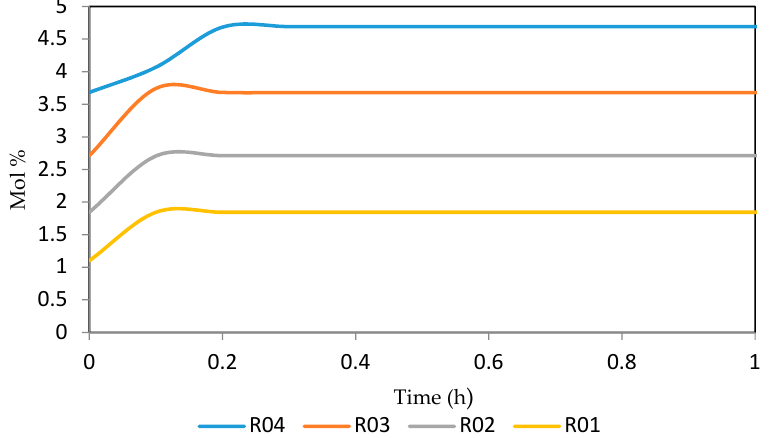
Figure 26. Dynamic behaviour of A 6 in the four reactors.